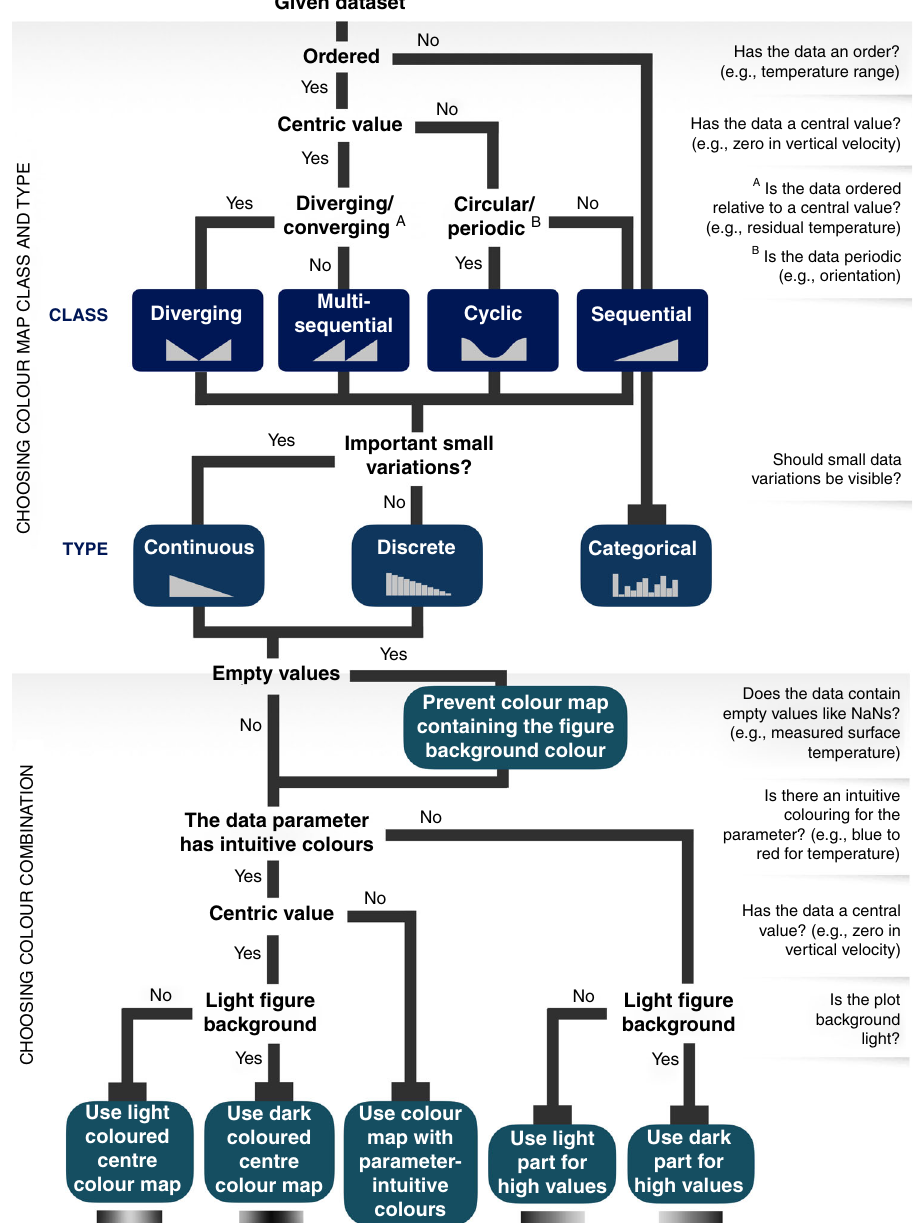
Fig. 6 Guideline for choosing the right scienti fi c colour map. For effective data representation, the nature of a given data set has to be matched by a suitable colour map class, type, and colour